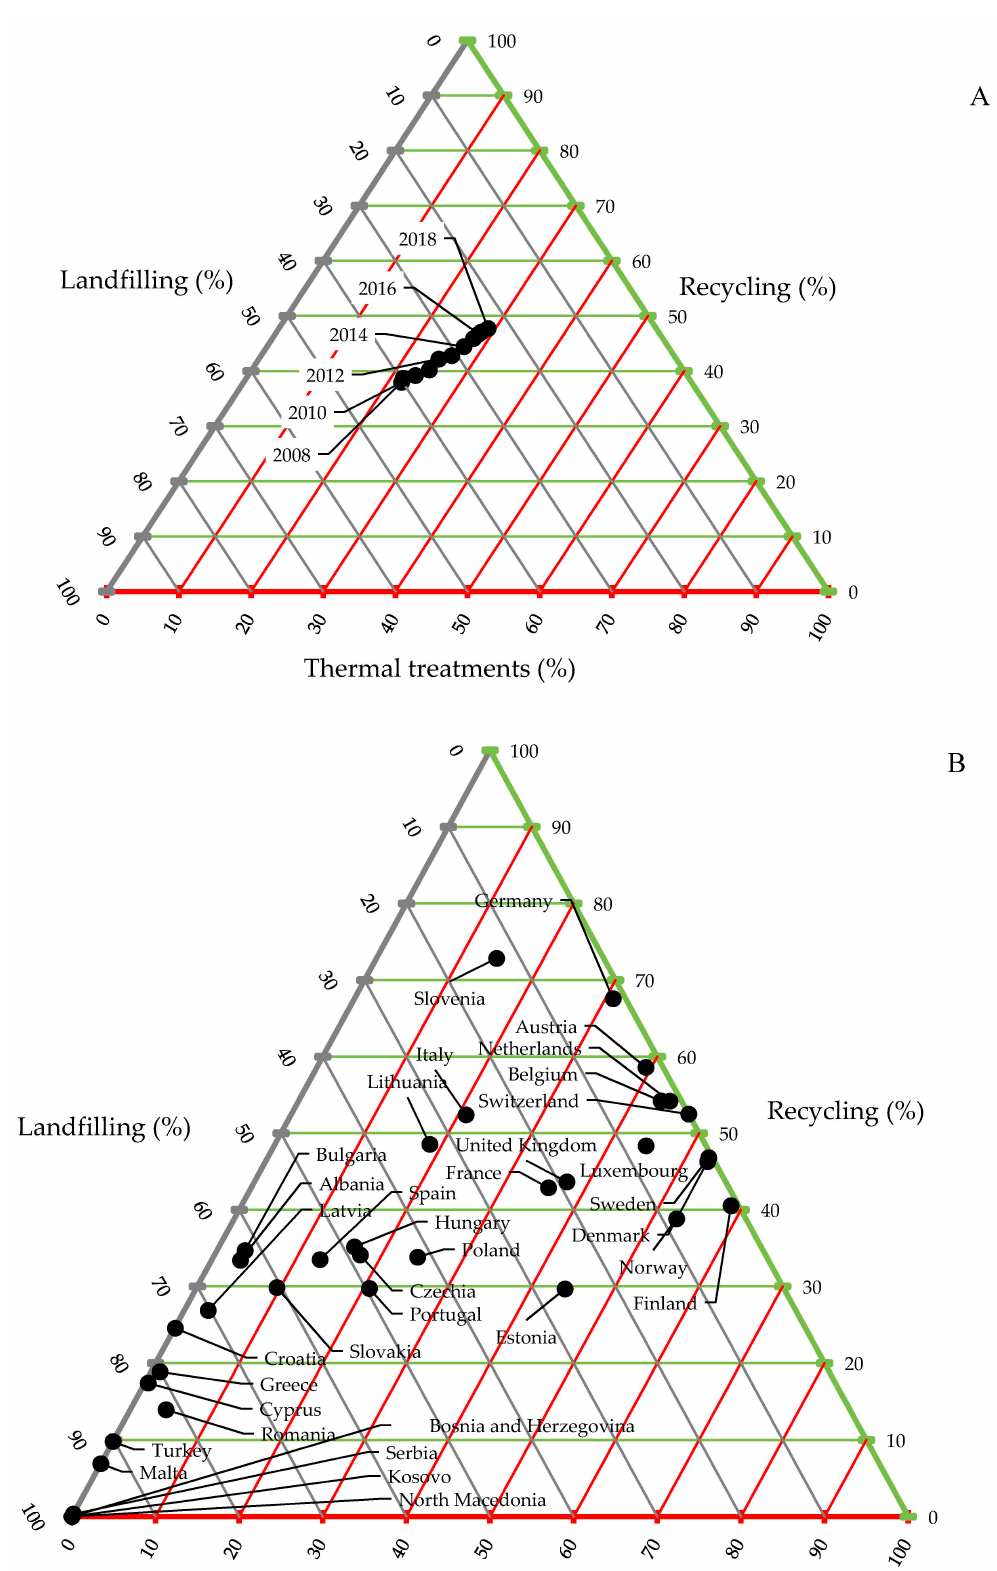
Figure 4. ( A ) MSW management operations in EU-28 in 2008–2018; ( B ) MSW management in member states in 2018 [1].